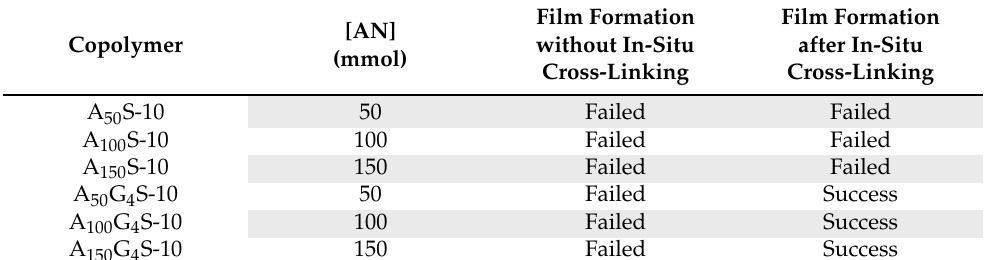
Figure 3. Schematic illustration of the cross-linking between the hydrophobic poly(acrylonitrile) (PAN) blocks and the formation of the secondary hydrophilic channels in the merged hydropho- bic domains. Table 1. Compositions and film-forming properties of A x S-10 and A x G y S-10 diblock ionomer